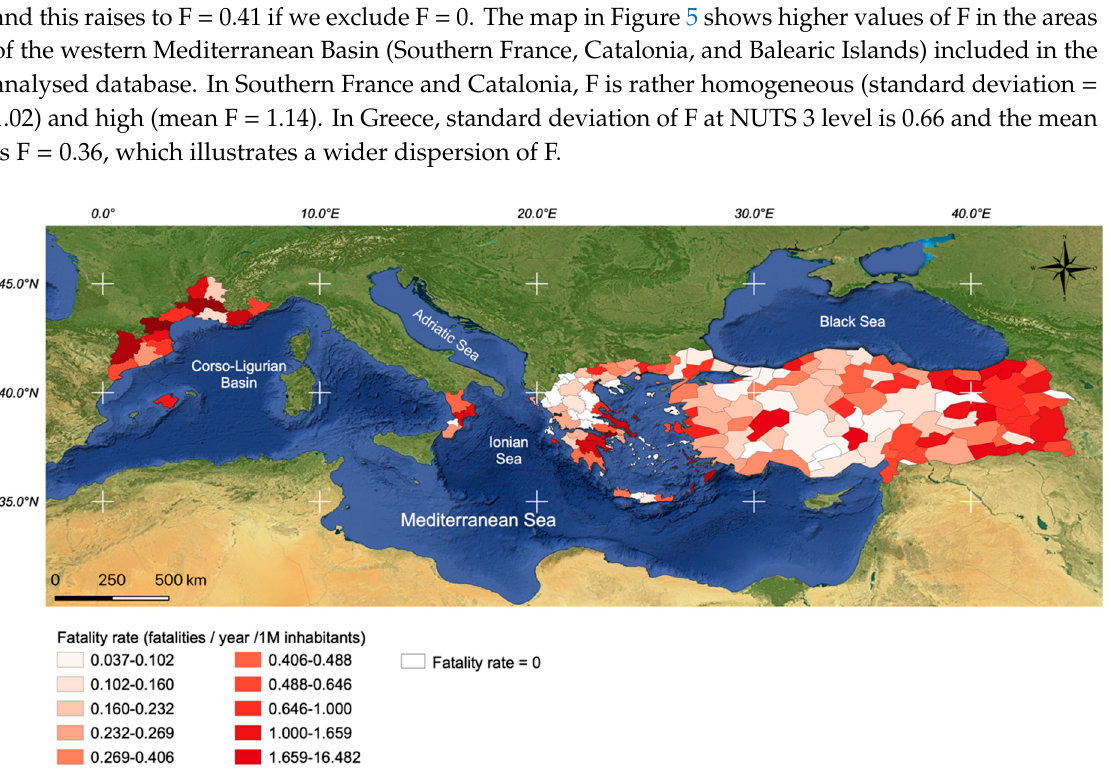
Figure 5. Fatality rate, F, by NUTS 3 regions, based on the decile classification excluding 0.00